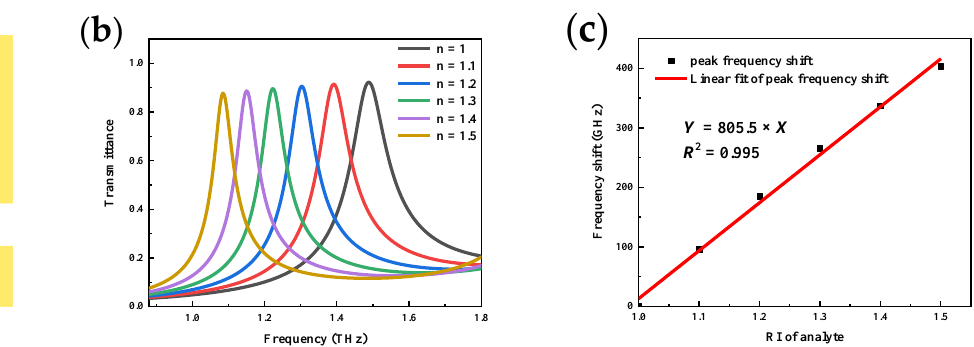
Figure 3. Simulation of metamaterial refractive index sensing performance: ( a ) Analyte filling situation; ( b ) Transmittance curve variation; ( c ) Peak frequency shift curve.